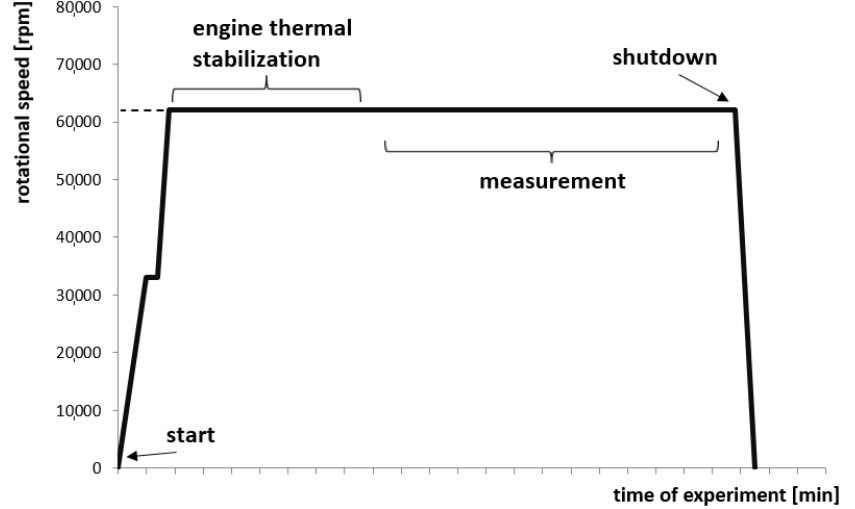
Figure 2. Engine test profile during dynamometer tests.